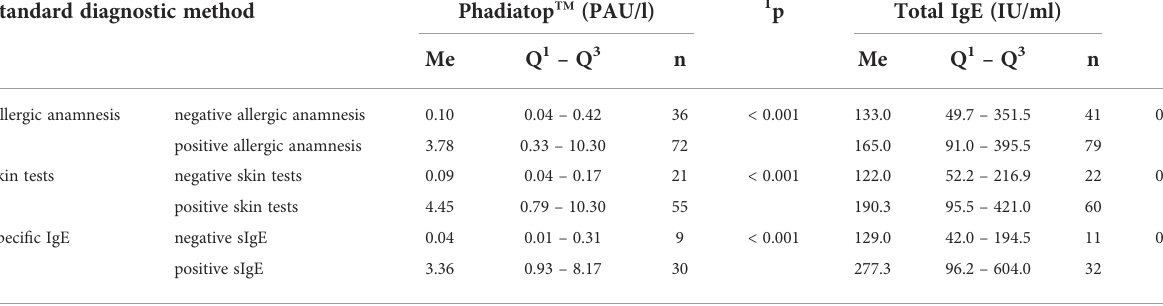
TABLE 3 Phadiatop ™ test results and standard diagnostic methods in different phenotypes of severe asthma. Standard diagnostic method